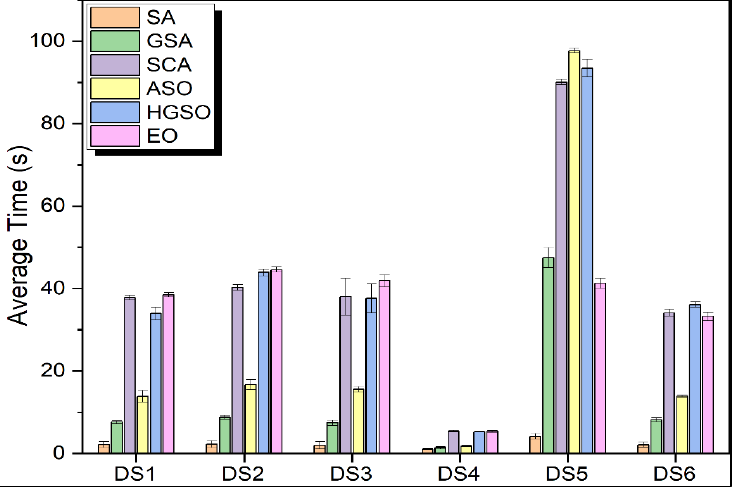
Figure 5. Average computational time and standard deviation of all algorithms on all selected datasets.